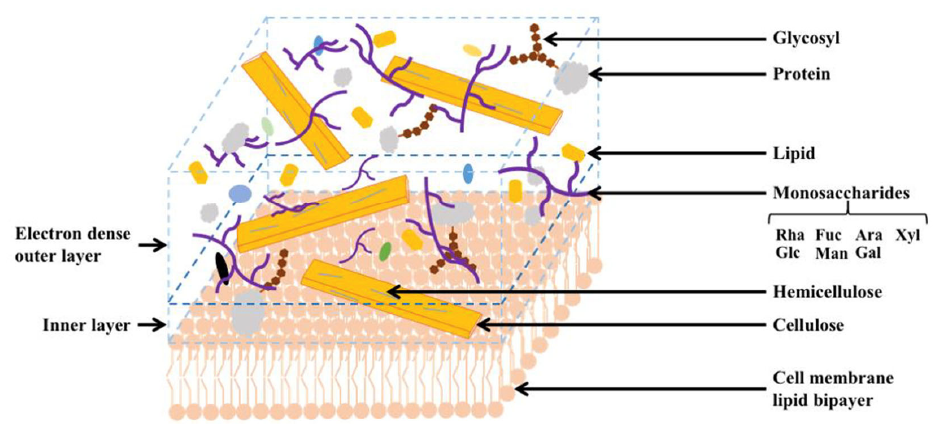
Figure 3. Cell wall structure and chemical compositions of Chlorella vulgaris . C. vulgaris cell wall has a unilamellar structure, consisting of an inner layer with an electron-dense outer wall and a low-density layer, and an outer layer with hairlike fibers. The cell wall of C. vulgaris is mainly composed of cellulose, hemicellulose, monosaccharides, lipid, protein, and glycosyl. As a glucosamine-type species, glucosamine is the main constituent of the cell wall of C. vulgaris, and proteins constitute about 20% of the cell wall.